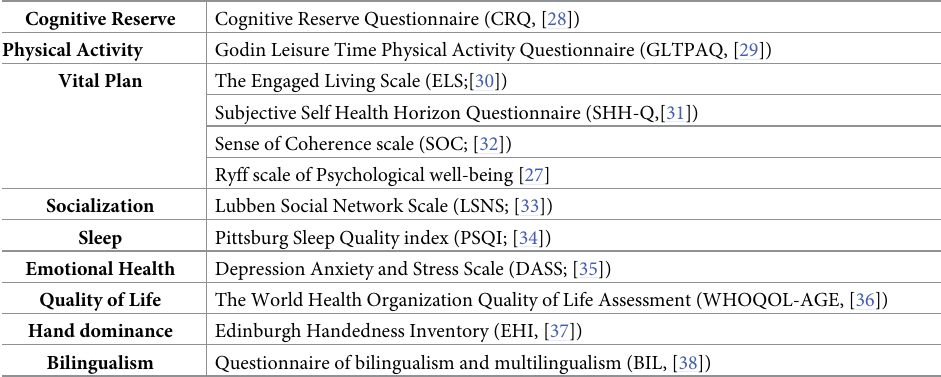
Table 2. Subsequent questionnaires characterizing various lifestyle domains.